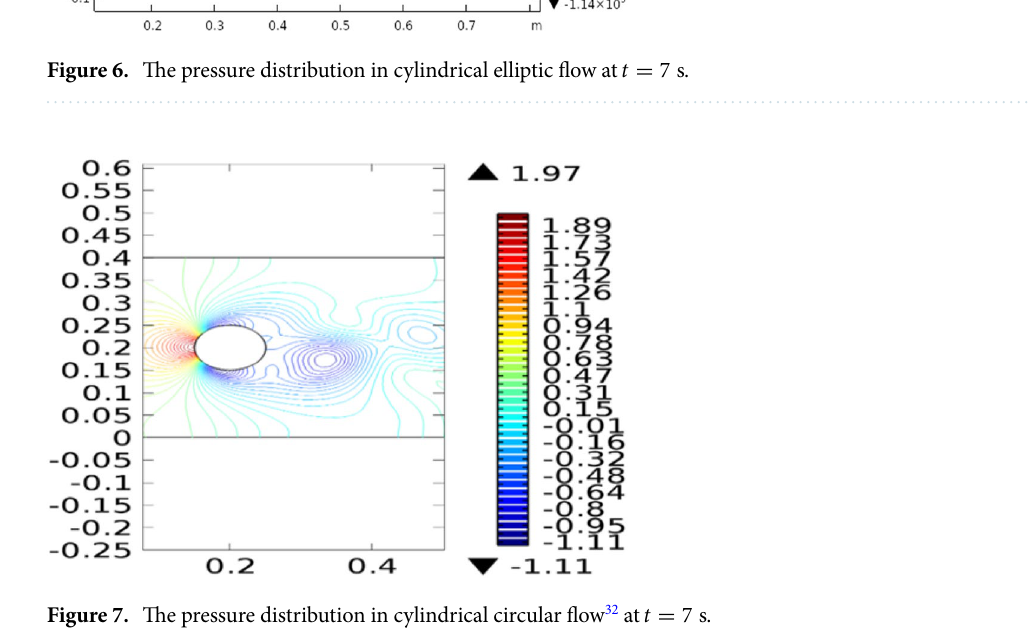
Figure 7. The pressure distribution in cylindrical circular flow 32 at t = 7 s .